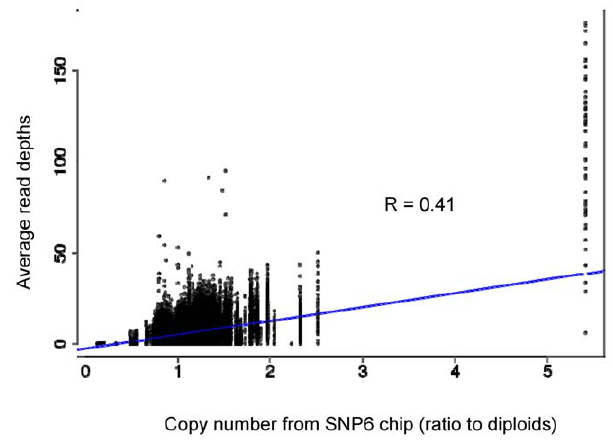
Figure 2. Comparison of sequencing read depth with copy number data in MDA-MB468 cell-line. Average sequencing read depths in capture regions were plotted against copy number data estimated from Affymetrix SNP 6.0 data as described in the methods section. The blue line shows the linear regression line. The Pearson correlation coefficiency (r=0.41) of sequencing read depth and copy number data is printed on the figure.